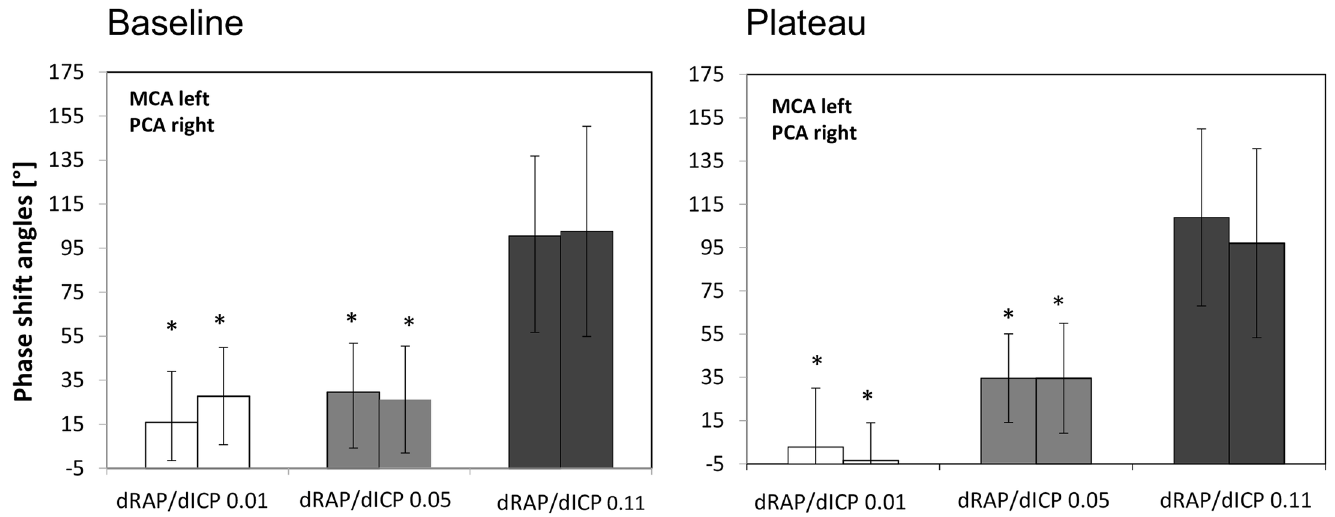
Fig 4. A and B — Comparison between patient subgroups with low, medium, and high pressure compliances at baseline (A) and plateau (B). M wave phase shift values in patients with low and medium pressure compliance e.g. gradients dRAP/dICP of 0.01 and 0.05/mmHg were significantly lower than in patients with gradients dRAP/dICP of 0.11/mmHg. Significant differences were marked with “ * ” .